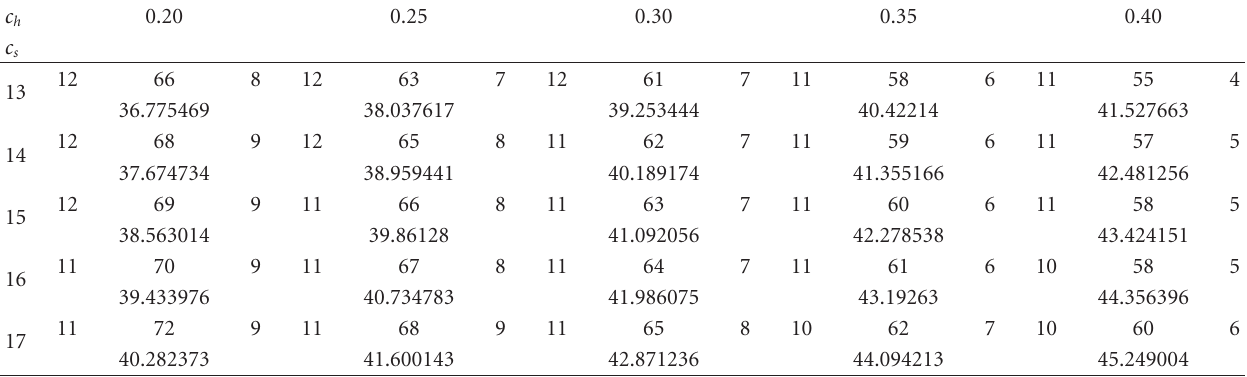
Table 13: Optimal values corresponding to various setup and holding costs ( c sh = 5, c p = 3, c pr = 0 . 3).